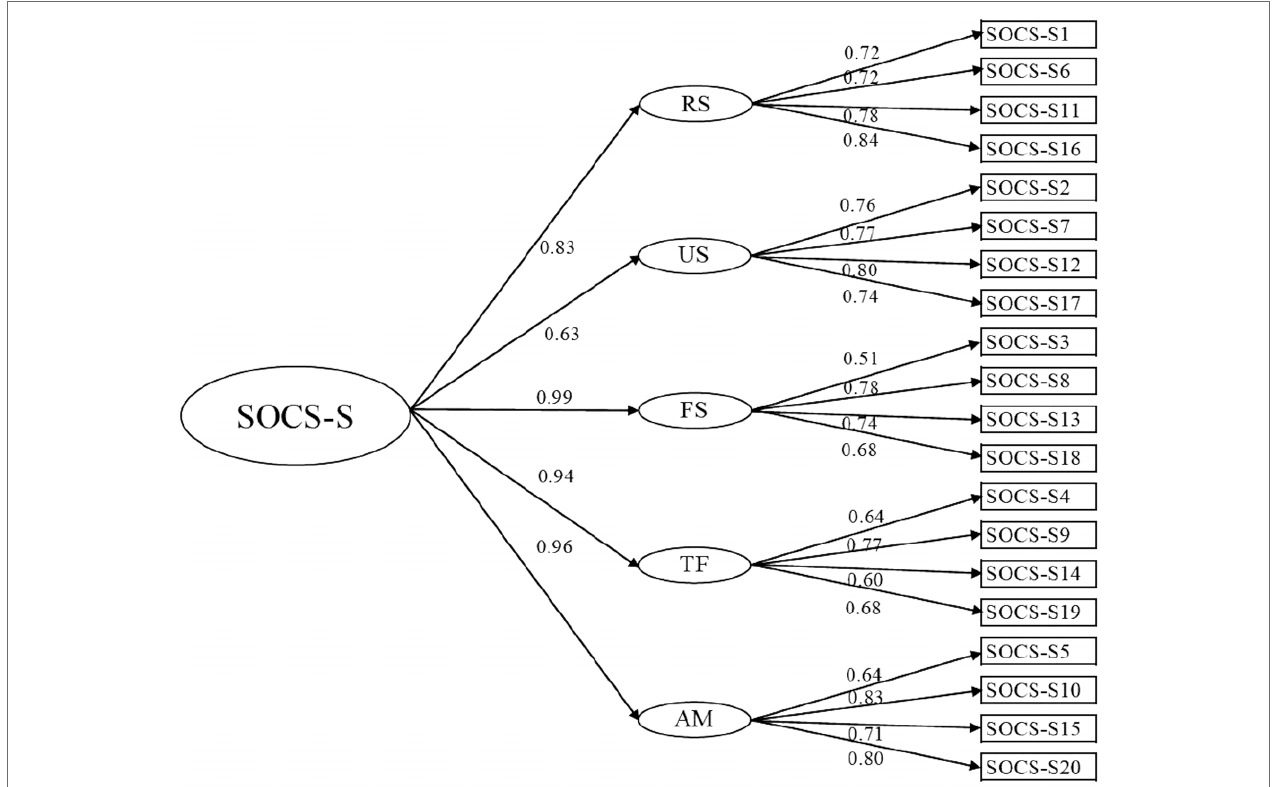
FIGURE 2 | Hierarchical five-factor model of the SOCS-S. Straight arrows: standardized item loadings. SOCS-S, Sussex-Oxford Compassion Scale for the Self; RS, recognizing suffering; US, understanding the universality of suffering; FS, feeling for the person suffering; TF, tolerating uncomfortable feelings; and AM, acting or being motivated to act to alleviate suffering.